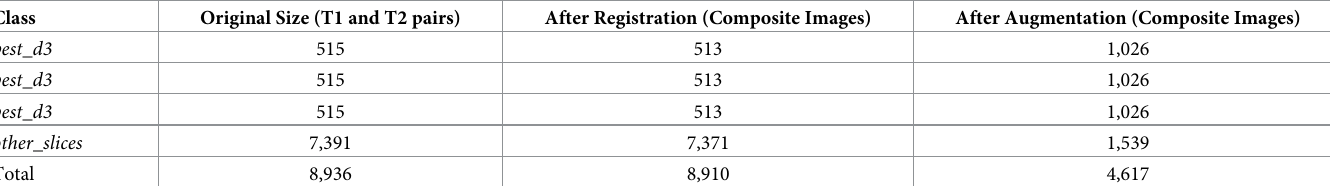
Table 2. Dataset sizes (number of images).